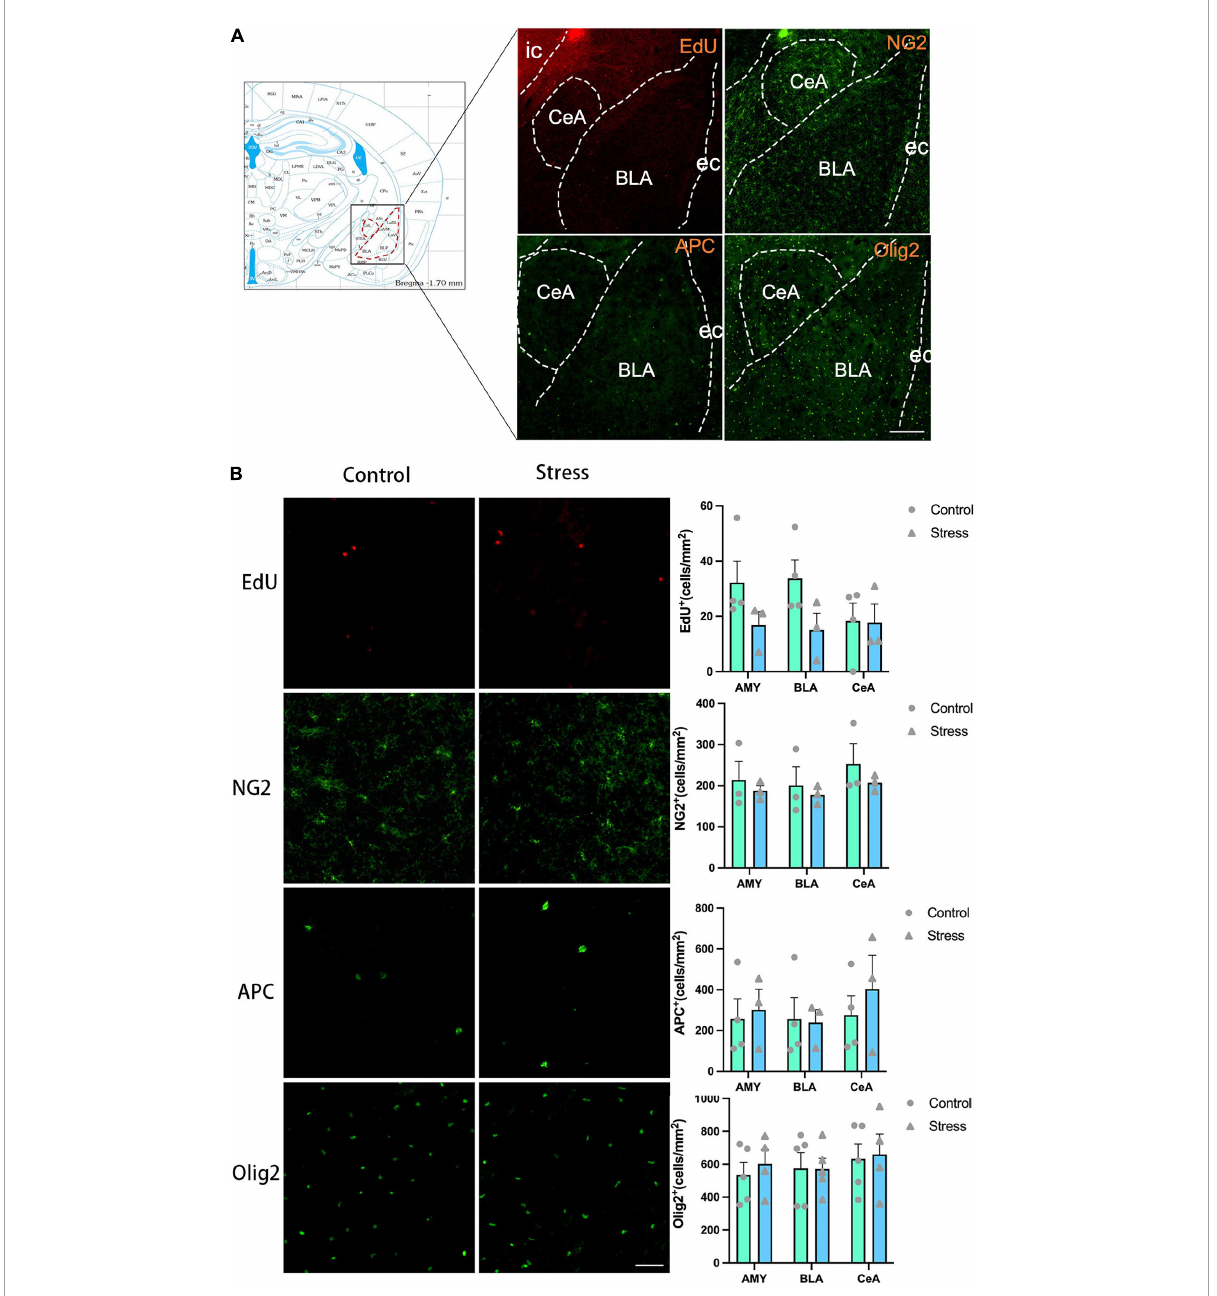
FIGURE7 The effects of chronic social defeat stress (CSDS) on the oligodendrocyte lineage cells in the amygdala (AMY) of adolescent mice. (A) Schemata showing the AMY regions for immunofluorescence and the representative images of immunofluorescence staining of EdU, NG2, APC, and Olig2. Magnification: 100 × . Scale bars: 200 µ m. (B) The representative images of immunofluorescence staining of EdU, NG2, APC, and Olig2 in the AMY (left panels) and the bar graphs showing the numbers of EdU + , NG2 + , APC + , and Olig2 + cells in the total AMY area (BLA + CeA), BLA and CeA areas (right panels). Magnification: 100 × . Scale bars: 50 µ m. Data are expressed as mean ± SEM. The number of animals used is as follow: EdU (control, n = 4; stress, n = 3); NG2 (control, n = 3; stress, n = 3); APC (control, n = 4; stress, n = 3); Olig2 (control, n = 5; stress, n = 4), Stress vs.